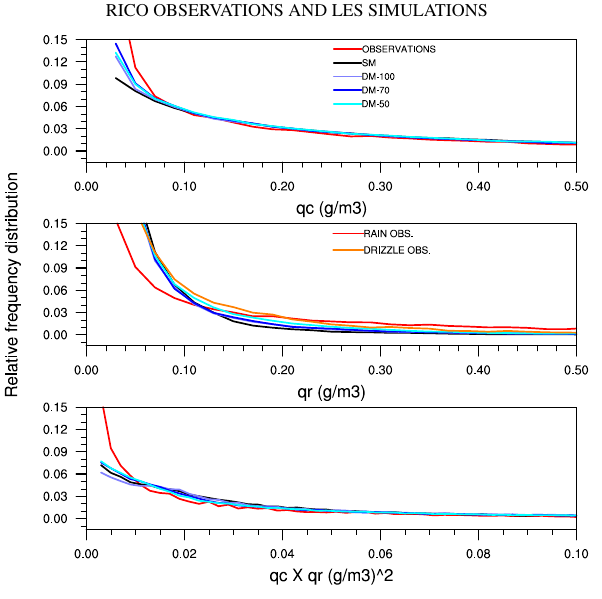
Fig. 12. Same as Fig. 7 for RICO. Figure 12: Same as Fig. 7 for RICO. Table 5. List of C-130 flights for RICO used in this study. Rain rates (RR) are from Snodgrass et al. (2009).